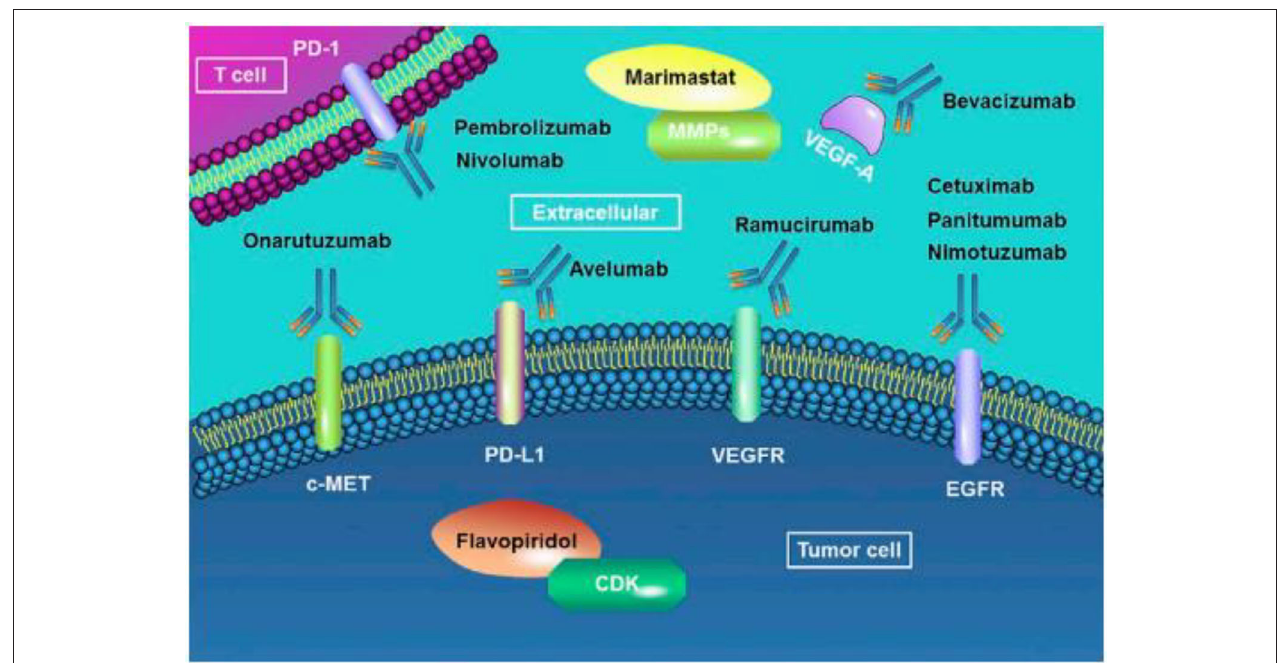
FIGURE 1 | Molecular-targeted therapies of gastric cancer. EGFR, Epidermal Growth Factor Receptor; VEGFR, Vascular Endothelial Growth Factor Receptor. Adopted from the study of Song et al. ( 33). cancer, suggesting the high immunogenicity of this subtype